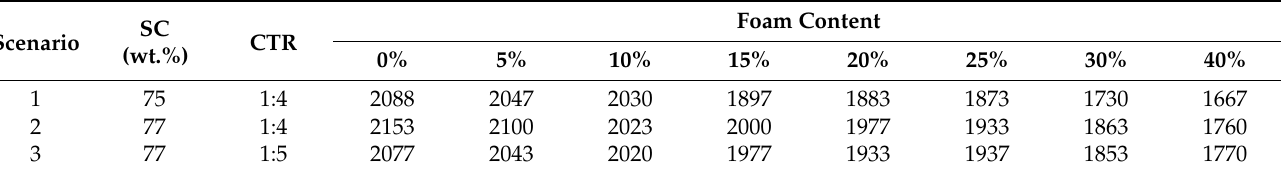
Table 5. Density of the FCPB